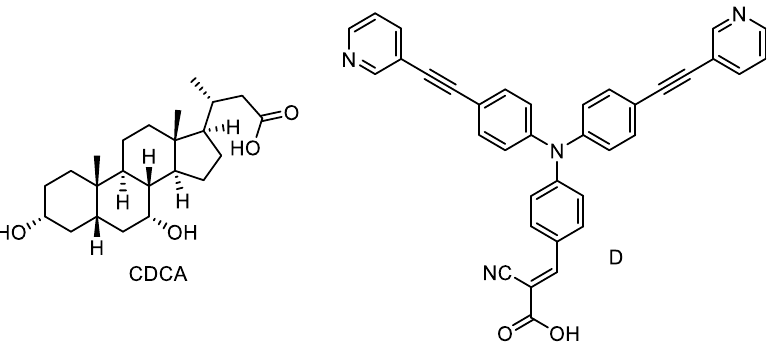
Figure 9. Chemical structures of CDCA are used as co-adsorbent, and D is used as a co-sensitizer.